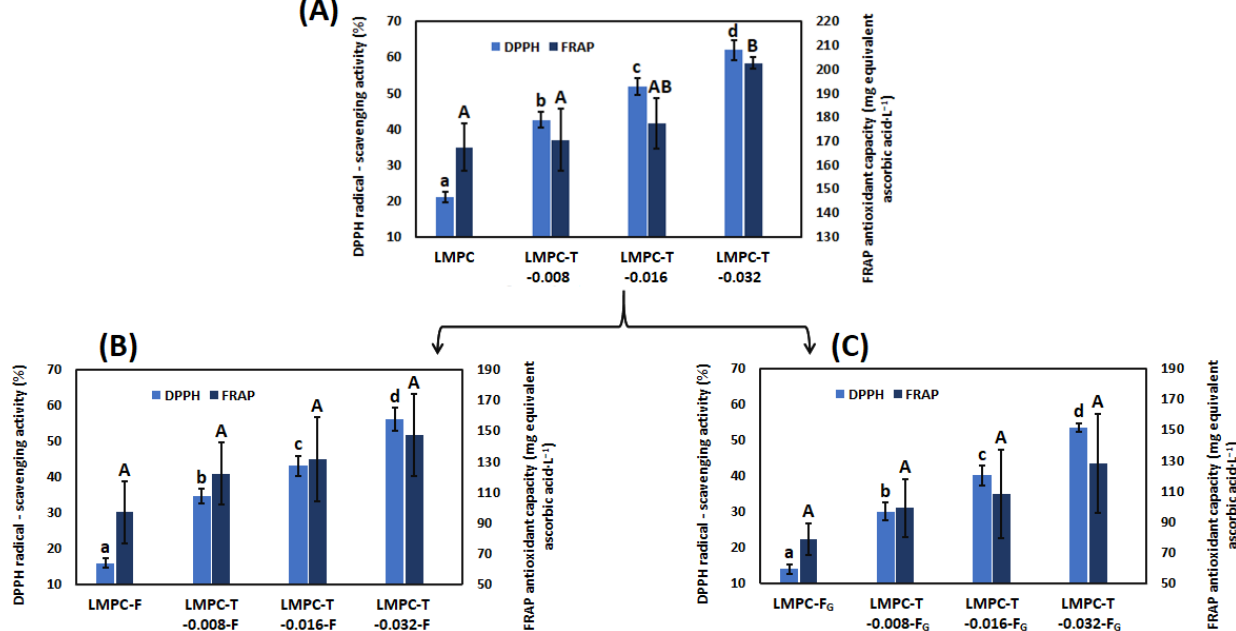
Figure 8. The antioxidant capacity of LMPC and LMPC-T ( A ), LMPC-F and LMPC-T-F ( B ) and LMPC- F G and LMPC-T-F G ( C ). Results are represented with a mean value and standard deviation (±values) of three triplicate experimental results. In superscript, the dissimilar alphabet represents significant differences between the results.